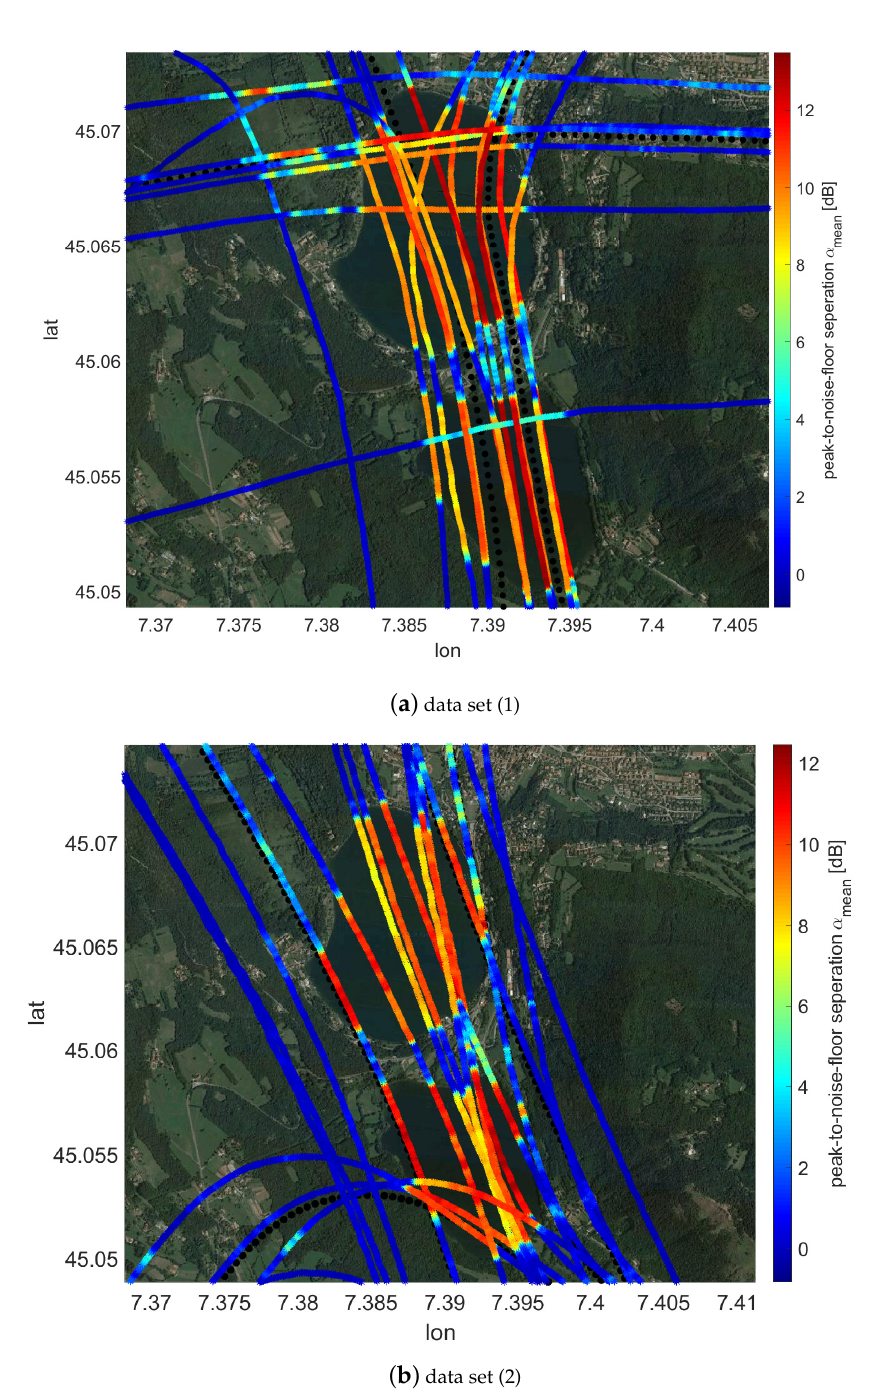
Figure 6. GNSS signals specular reflection points superimposed into an orthophotomap. The colorgrades indicate the measured reflected power α mean